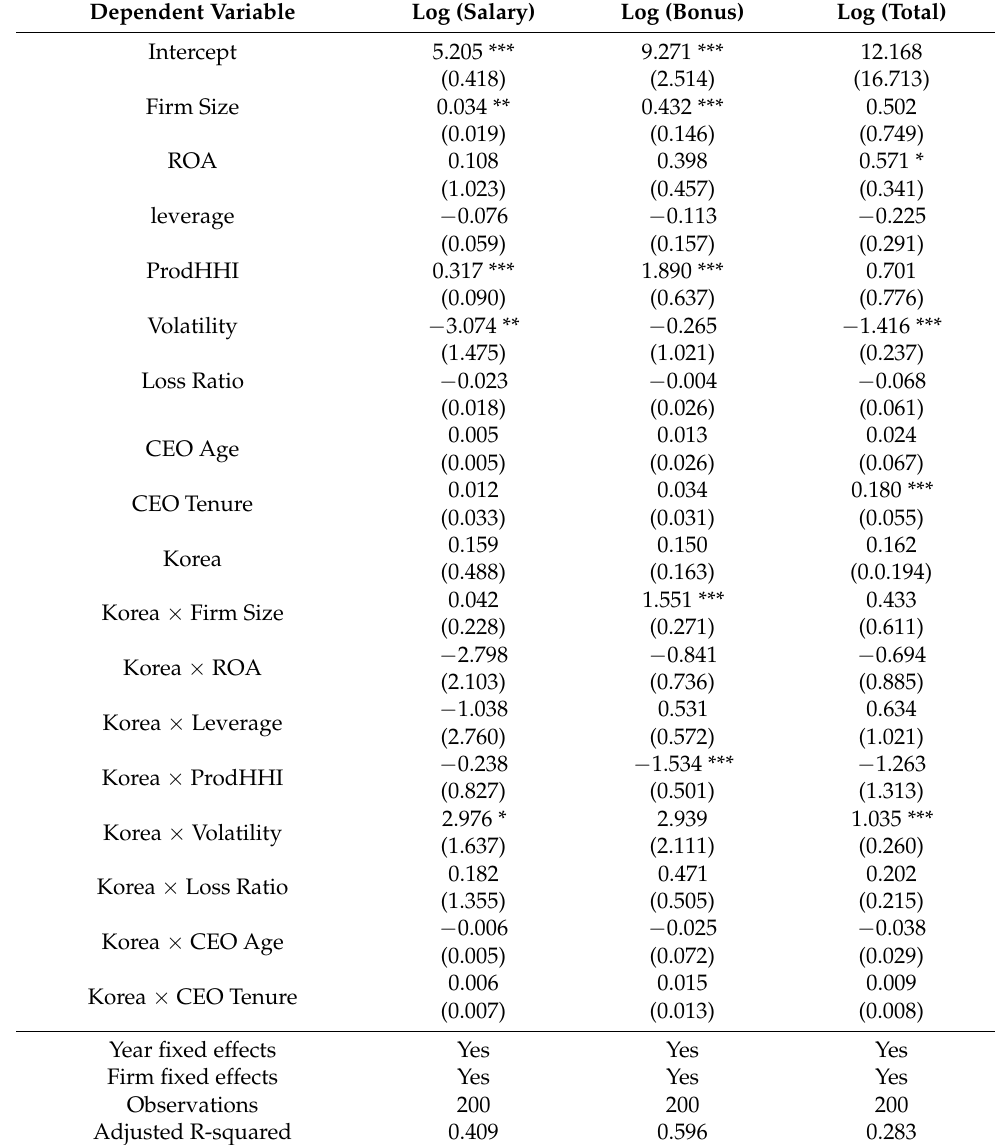
Table 7. Comparison of Determinants of CEO Compensation using the Bootstrap